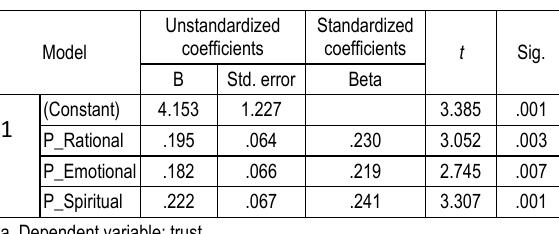
Table 6. Partial test ( t -test) of the second equation Model